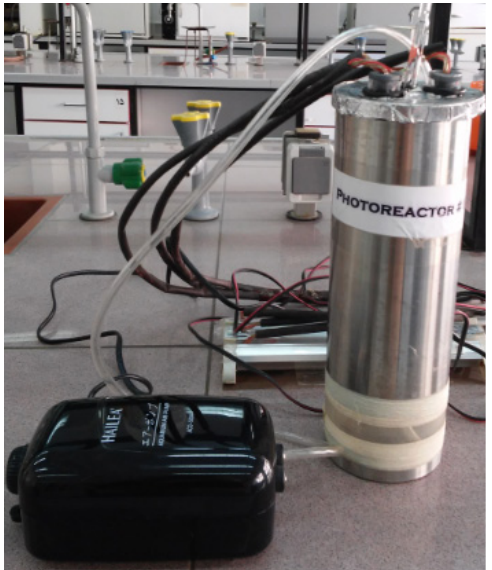
Fig. 1. Photoreactor used in the experiments